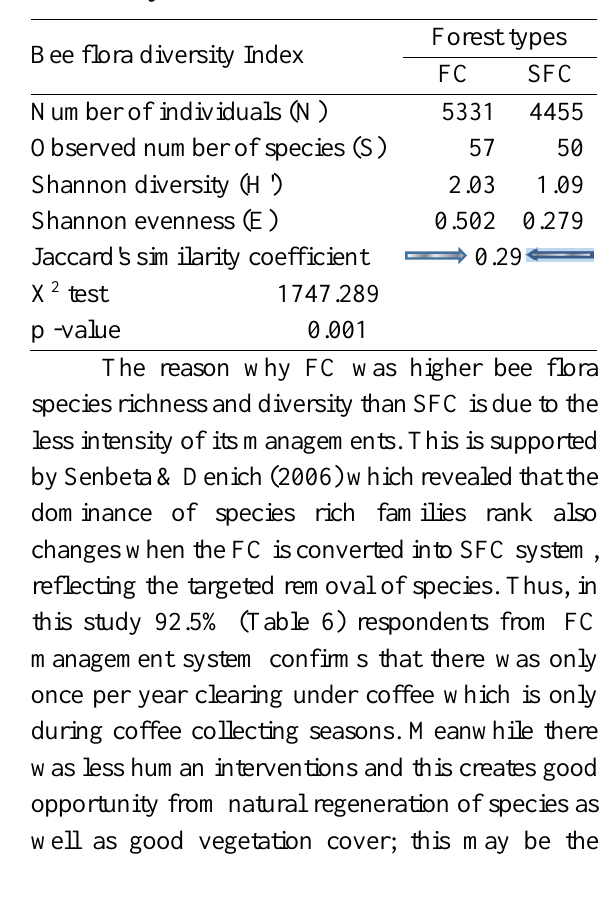
Table 5 Shannon diversity index for bee